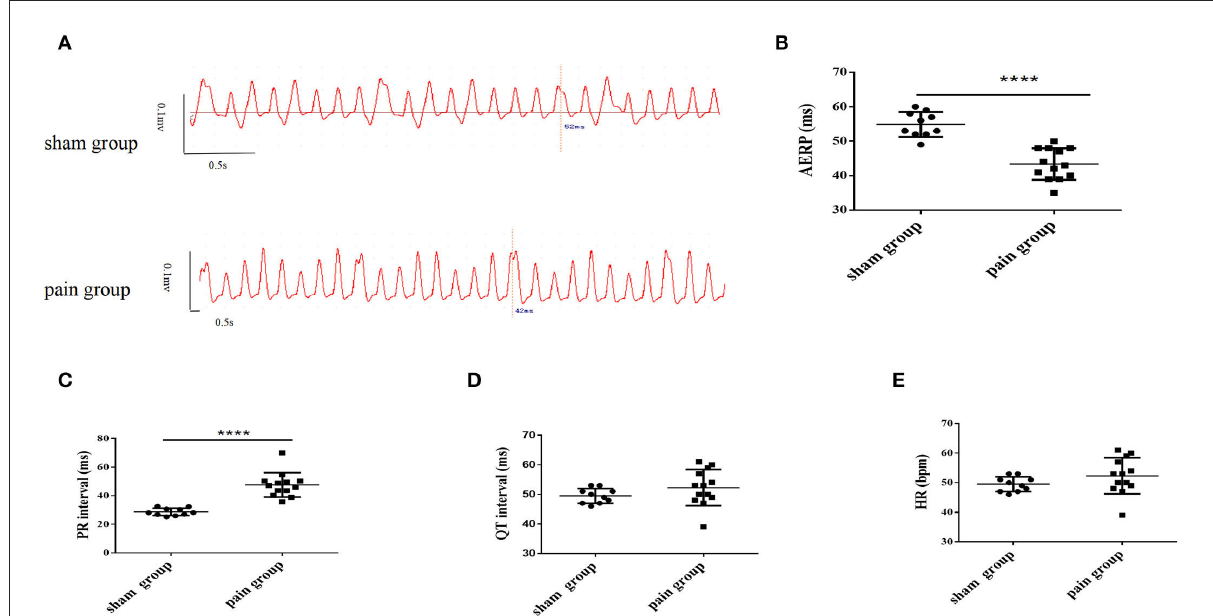
FIGURE1 The measurement of left atrial bipolar cardiogram and basic characteristics of the electrocardiogram from lead II. (A) The left atrial effective refractory period (AERP) measured from the bipolar cardiogram (BCG) in sham and pain groups; (B) the AERP obtained from the BCG; the measurement of (C) PR interval, (D) QT interval, and (E) heart rate obtained from the surface ECG lead II in the sham and pain groups. The results are expressed as mean ± standard deviation. The scatter plot represents values from individual mice, with horizontal bars and error bars showing means and standard errors of the mean, respectively. **** represents p < 0.0001 (two-tailed Student’s t